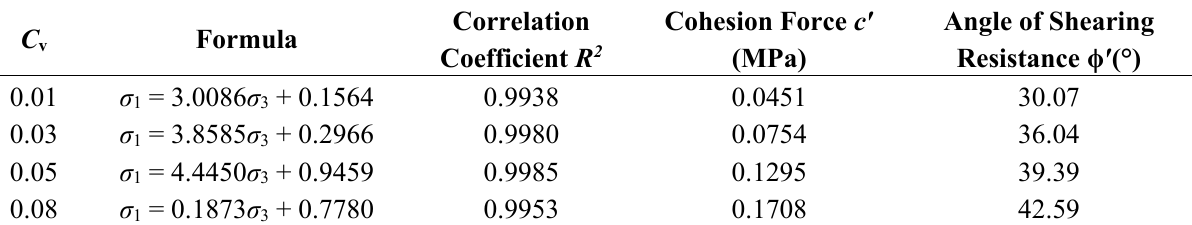
Figure 8. The peak stress of samples under different conditions. Table 4. Values of R 2 , c ′ and ϕ′